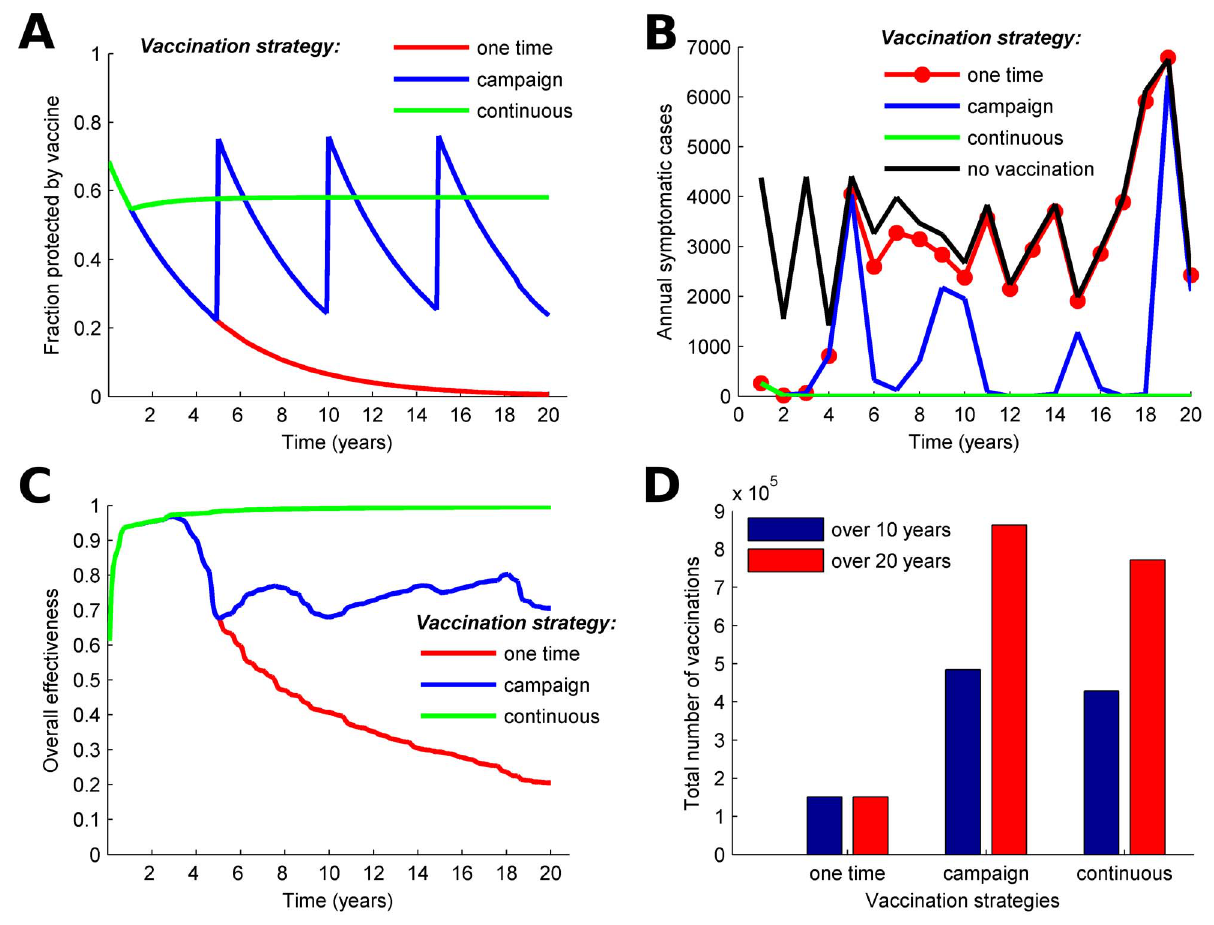
Figure 3. Comparison of one-time mass vaccination, vaccination campaigns that occur every 5 years, and continuous vaccination. The one-time vaccination targets 70% of the vaccine-eligible population (those one year old and older) for vaccination, the 5-year campaigns target 70% of the population every 5 years, and the continuous vaccination strategy targets 70% of the population at the beginning of the first year then vaccinates at a constant rate starting in year 2. Vaccine is less effective for children aged 1–4 (40% efficacy) than for older children and adults (65% efficacy). Temporal dynamics of A) the fraction of the population protected by vaccine; B) annual cholera cases; C) the overall effectiveness in terms of prevented fraction of cholera cases when different vaccination strategies are implemented; and D) total number of vaccinations for different strategies over 10 and 20 years.